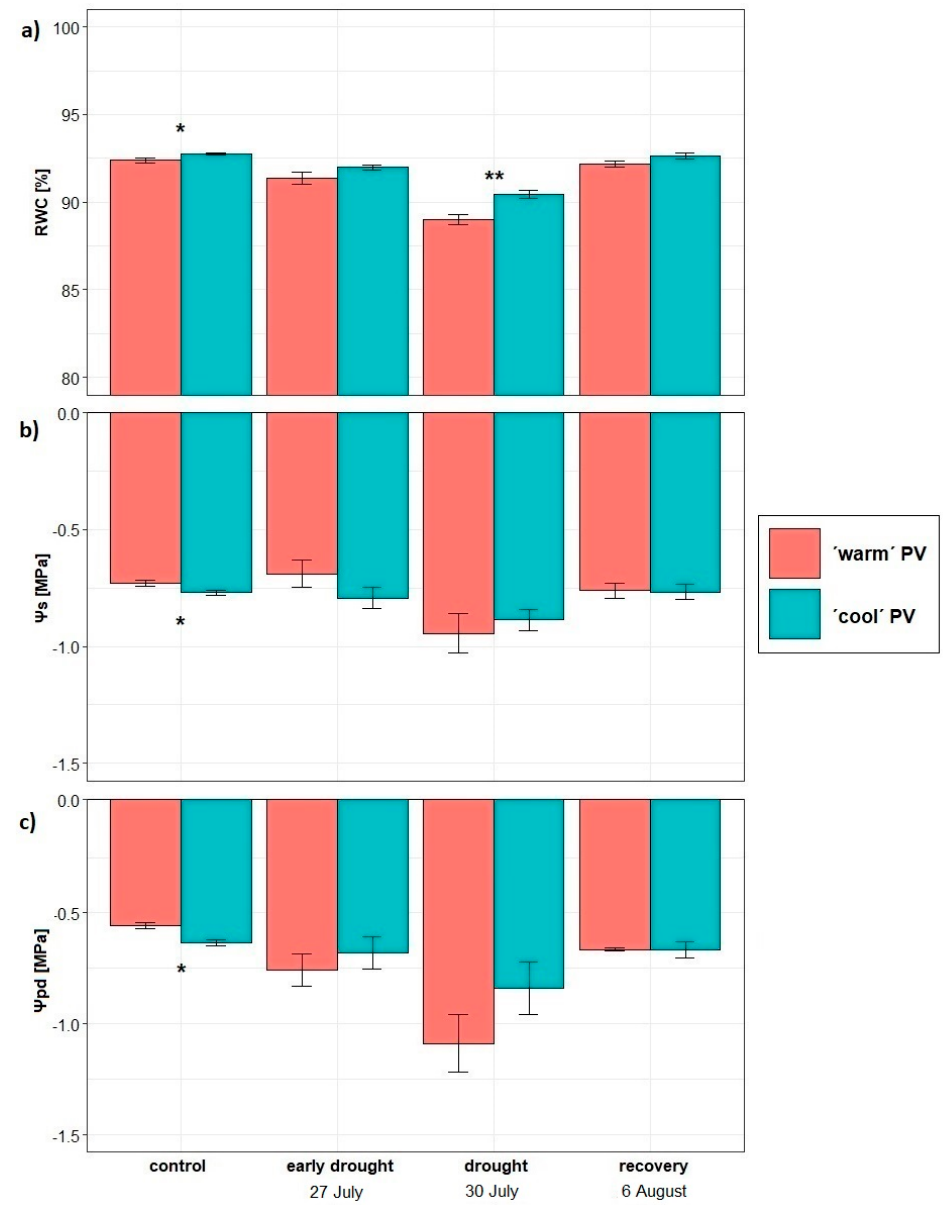
Figure 1. The provenance mean ± standard error of ( a ) RWC, ( b ) Ψ pd , and ( c ) Ψ S in the control condition, at the end of early drought (27 July), drought (30 July), and in the recovery period (6 August). Asterix marks the significant difference between provenances. Provenances are identified by different colors: ´warm´ PV (red), ´cool´ PV (blue) .